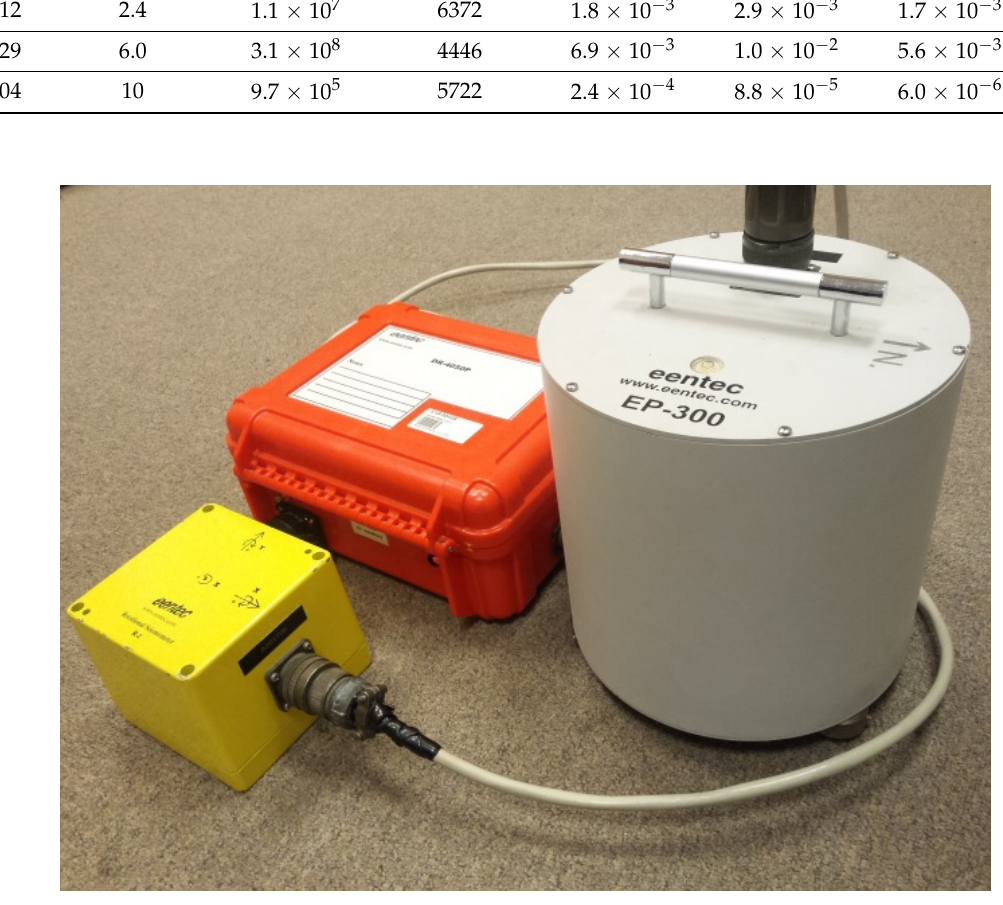
Figure 2. System for 6-DOF measurements installed in the Rudna mining region. Y-axes of both translational and rotational seismometers were directed into the north direction, while the X-axes were facing the west. The rotational seismometer, due to its low weight, was grouted to the floor to ensure proper measurements. More details about the measuring system were presented in reference [42].